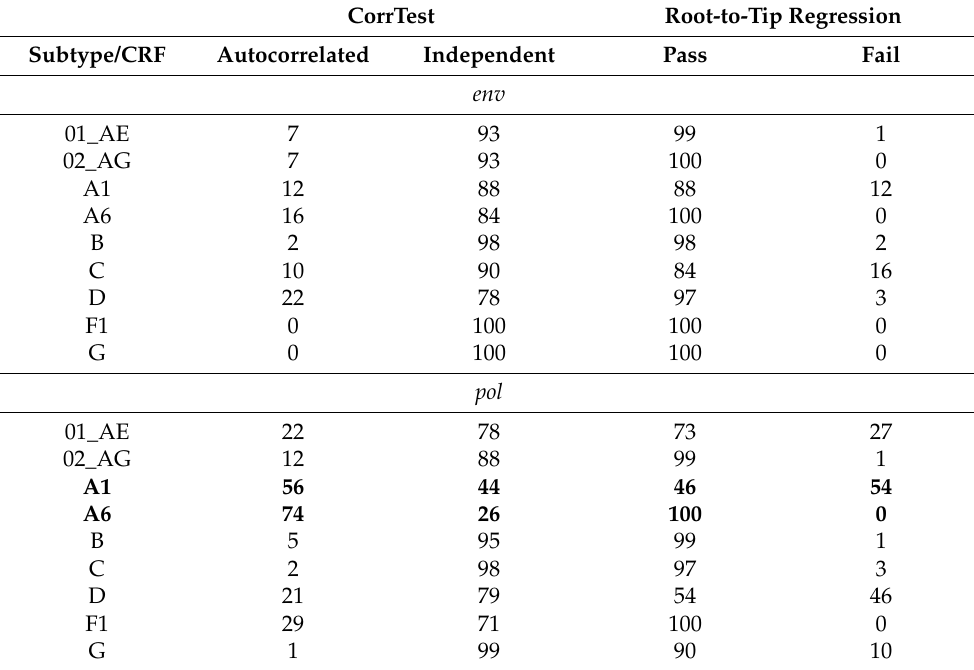
Table 1. Evidence of temporal signal and autocorrelated rates on phylogenetic trees. The values in the table show how many of the 100 trees for each subtype/CRF failed the RTT test (i.e., either negative slope or r < 0.3) or indicated evidence of autocorrelated rates, tested via the CorrTest program [26]. A6 and A1 are bolded, as >50% of these trees indicated either evidence of rate autocorrelation or failed RTT tests. See Table S1 for complete data.